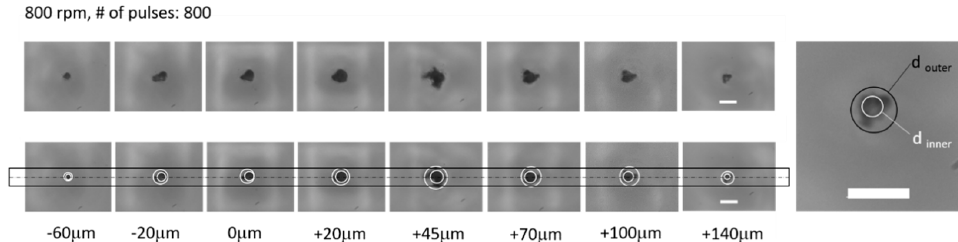
Figure 6. Micropores were ablated with the same laser parameters, except for the vertical distance of the beam focus. This height difference ranged from − 60 to +140 µm with 0 as a reference plane. Within steps of 5 µ m around a +45 µ m off-set, the aperture size maintained an inner diameter between 3 and 4 micrometers (not all results are shown), so a +45 µ m off-set from the reference plane was chosen for subsequent experiments.